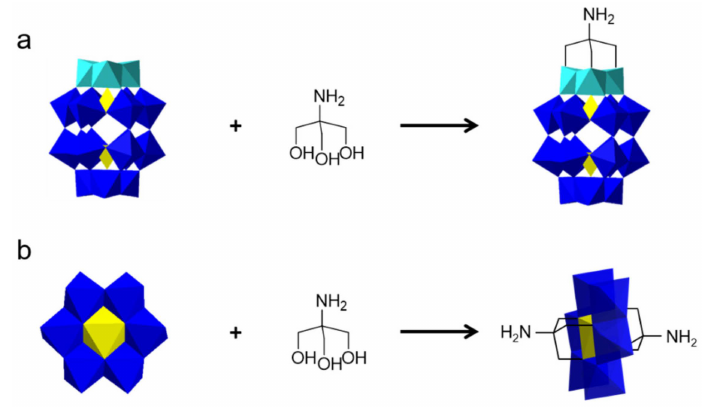
Figure 6. Preparation of POM-based monomer by esterification. ( a ) Dawson-type POMs; ( b ) Anderson-type POMs. Reproduced with permission from [58]. Copyright (2019)